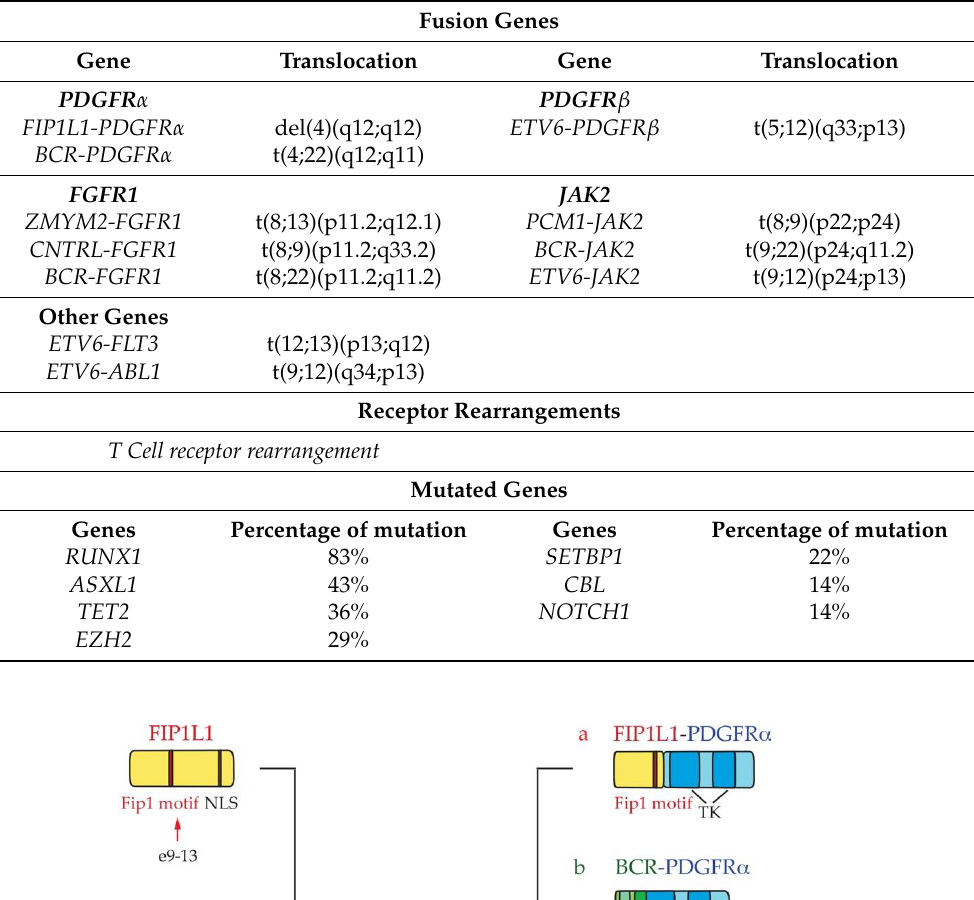
Table 1. Molecular pathogenesis in Hypereosinophilic Syndrome.